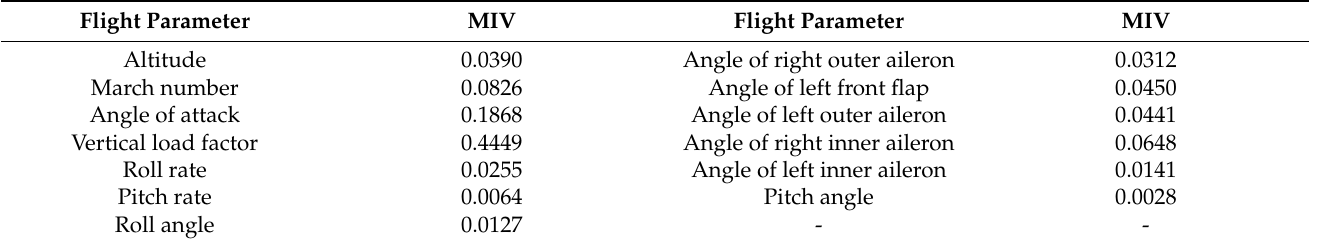
Table 4. Normalized mean impact values of 13 flight parameters.